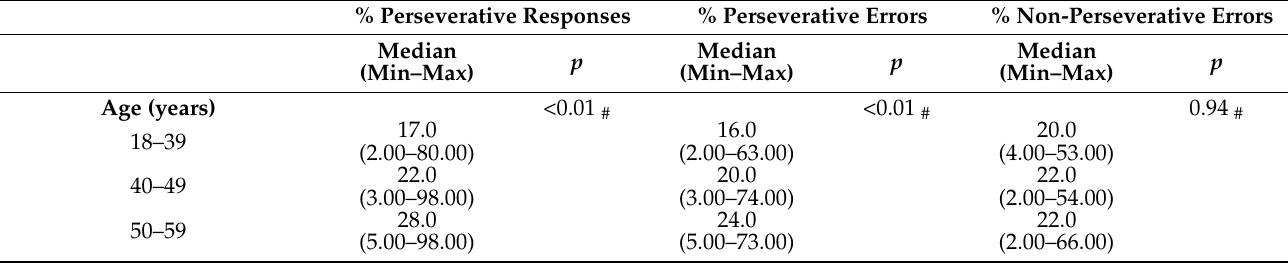
Table 2. Comparison of Wisconsin Card Sorting Test results by socio-demographics, working conditions, and history of decompression illness (fishermen and divers; N =